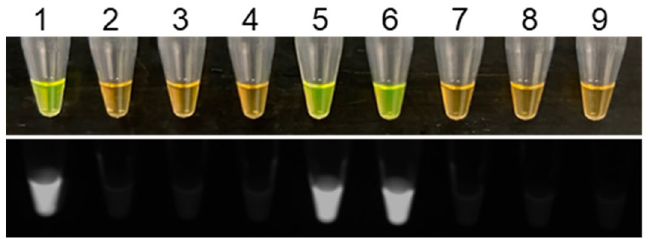
Figure 10. Detection of Dickeya fangzhongdai in naturally infected taro samples. Positive amplification was observed with D. fangzhongdai CFBP8607 T (positive control, tube 1) and two D. fangzhongdai -infected taro samples (tubes 5 and 6); no SYBR GREEN color change or fluorescence were observed for non-infected taro samples (tubes 2–4), healthy taro (tube 8) and NTC (non-template control; water; tube 9). No false positives and false negatives were